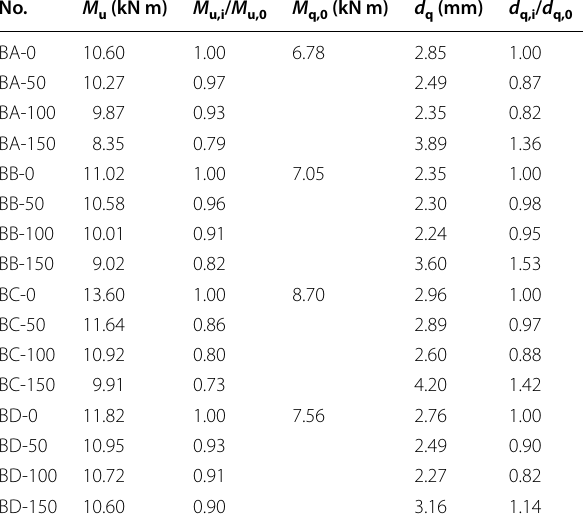
Table 6 Comparison of bending capacity and deflection— taking unfrozen specimen as control